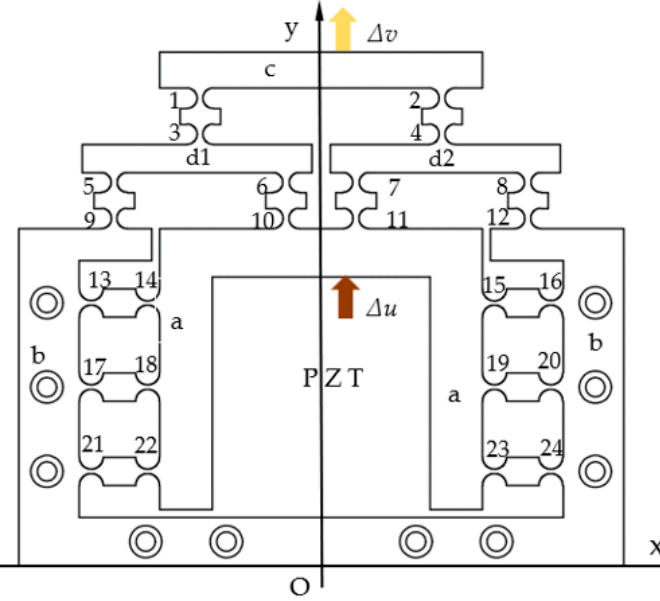
Figure 2. Schematic diagram of the micro-drive reduction mechanism.